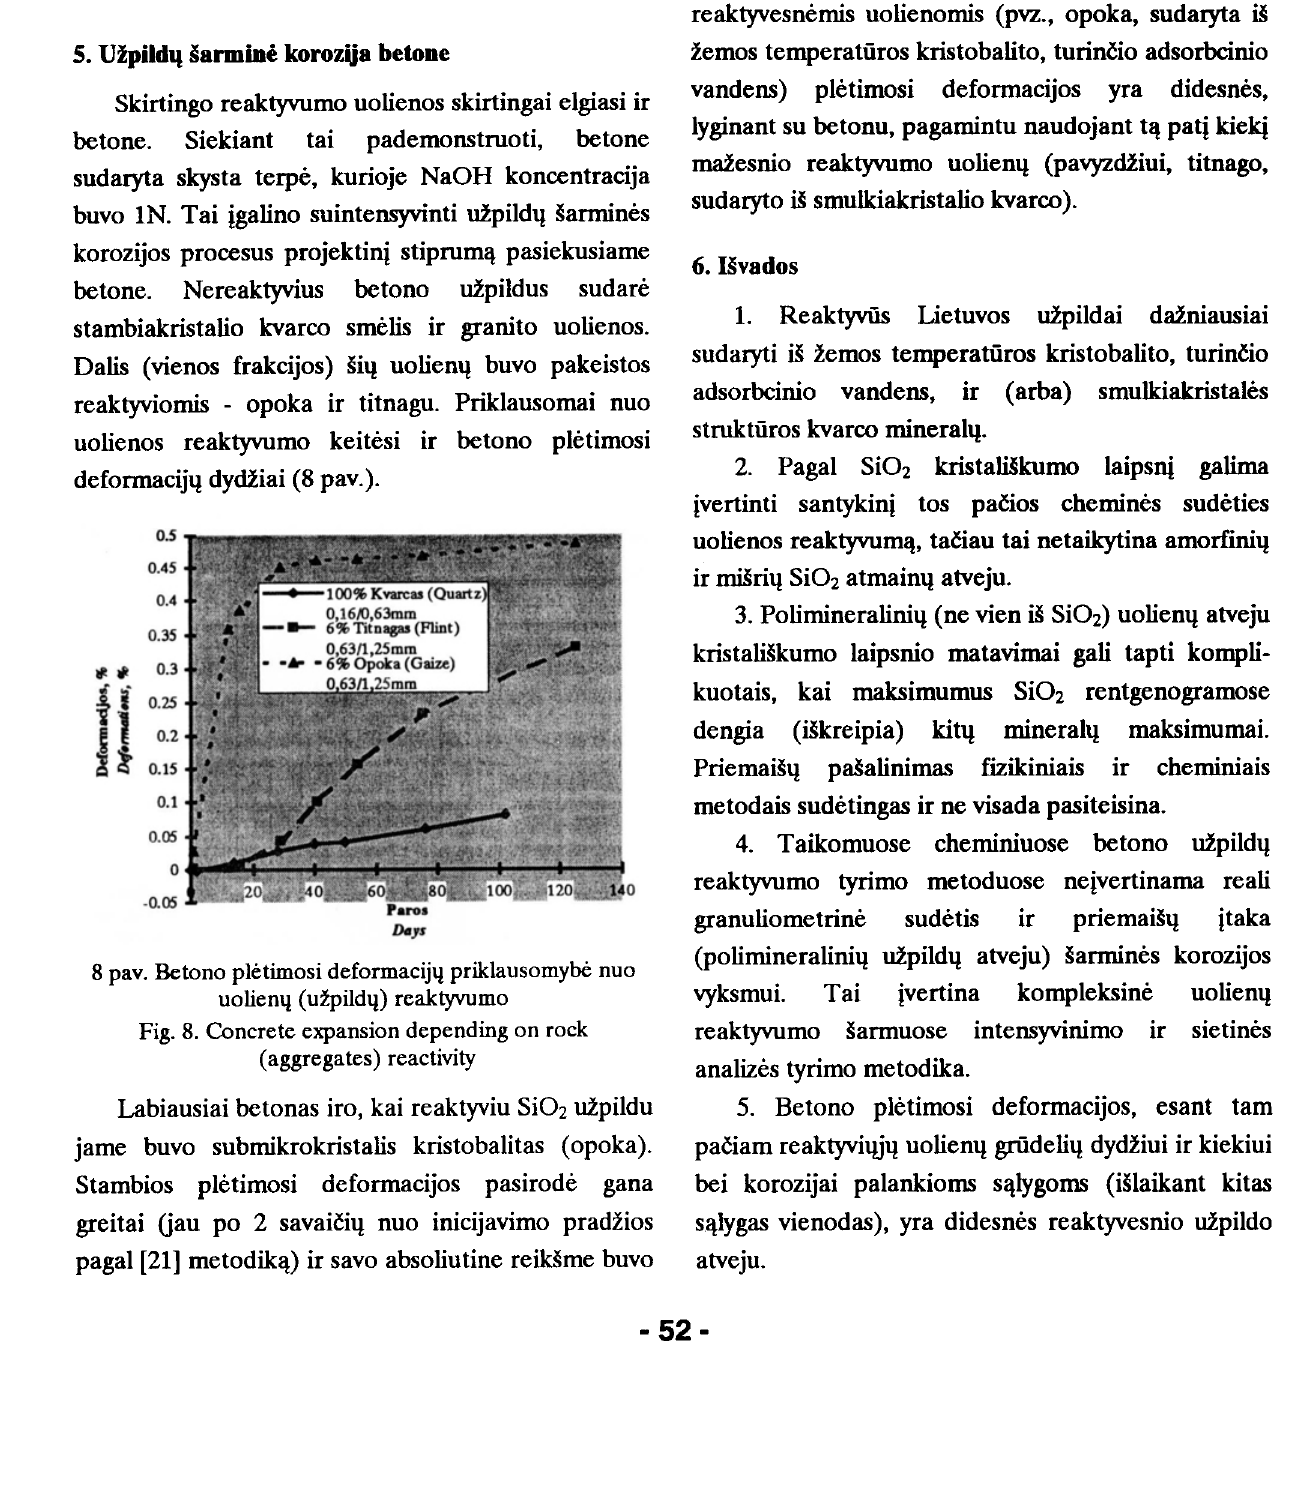
Fig. 8. Concrete expansion depending on rock (aggregates)